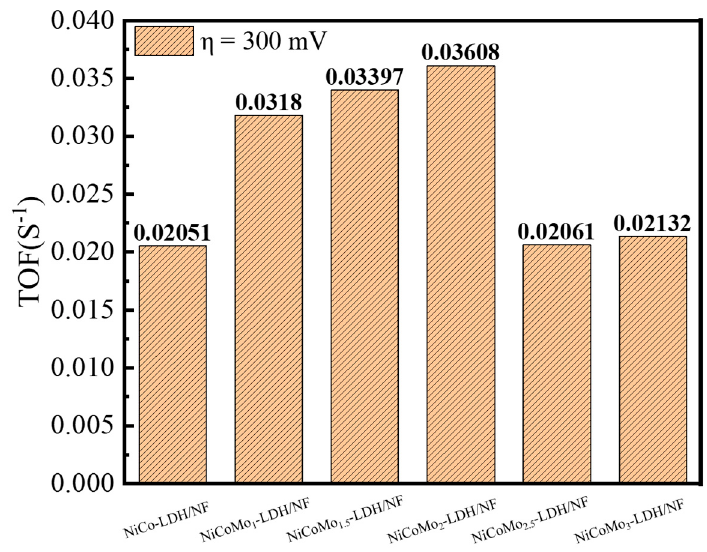
Figure 7. TOF values of different Mo-doped electrode catalysts at an overpotential of 300 mV. Table 1. More comparison of OER performance of different nickel- or cobalt-based electrocatalysts (overpotentials η calculated by using the formula η = E RHE − 1.23 V).